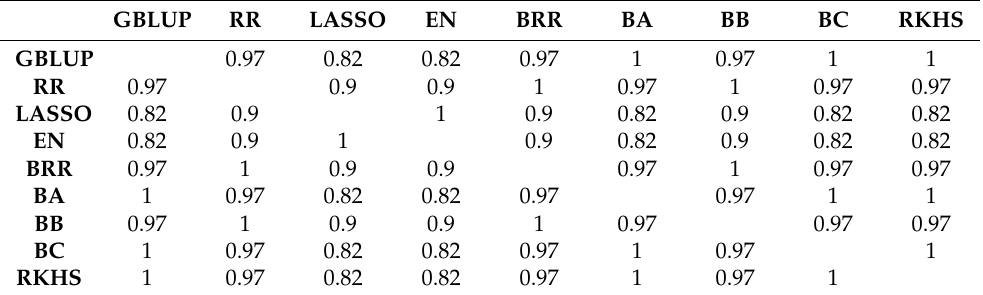
Figure 4. Unweighted Pair Group Method with Arithmetic Mean cluster dendrogram based on the predictive abilities of the different genomic prediction methods. Table 4. Spearman rank correlation coefficients between GEBVs for all genomic prediction methods.